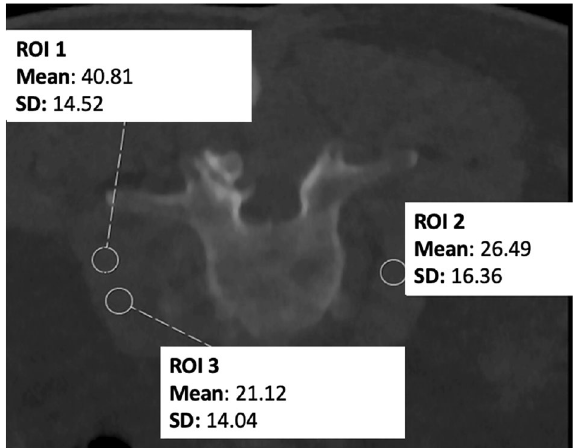
Figure 3. Measurement of image noise for a planned lumbosacral biopsy. Three measurements within the psoas muscle were performed to derive attenuation values from manually placed circular regions of interest (ROIs).